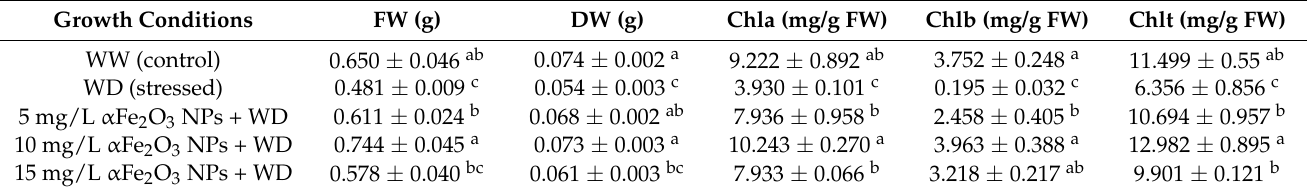
Figure 3. Phenotypic representation ( A ) and plant height ( B ) of sorghum plants under drought stress, grown from seeds primed with α Fe 2 O 3 NPs. WW = well-watered (control); WD = water-deprived (drought stress); 5 WD = water-deprived + 5 mg/L α Fe 2 O 3 NPs; 10 WD = water-deprived + 10 mg/L α Fe 2 O 3 NPs; 15 WD = water-deprived + 15 mg/L 2 O 3 NPs. Data in the figure represent the mean ± standard deviation ( n = 3). Different letters indicate significant differences ( p < 0.05) based on ANOVA one-way variance analysis followed by Tukey’s comparison test. Table 1. Effect of α Fe 2 O 3 NP priming on the growth parameters of sorghum plants under drought stress. Growth parameters include fresh weight (FW), dry weight (DW), and chlorophyll (Chl) content. Data in the table represent the mean ± standard deviation ( n = 3). Different letters in the column indicate significant differences ( p < 0.05) based on ANOVA one-way variance analysis using Tukey’s comparison